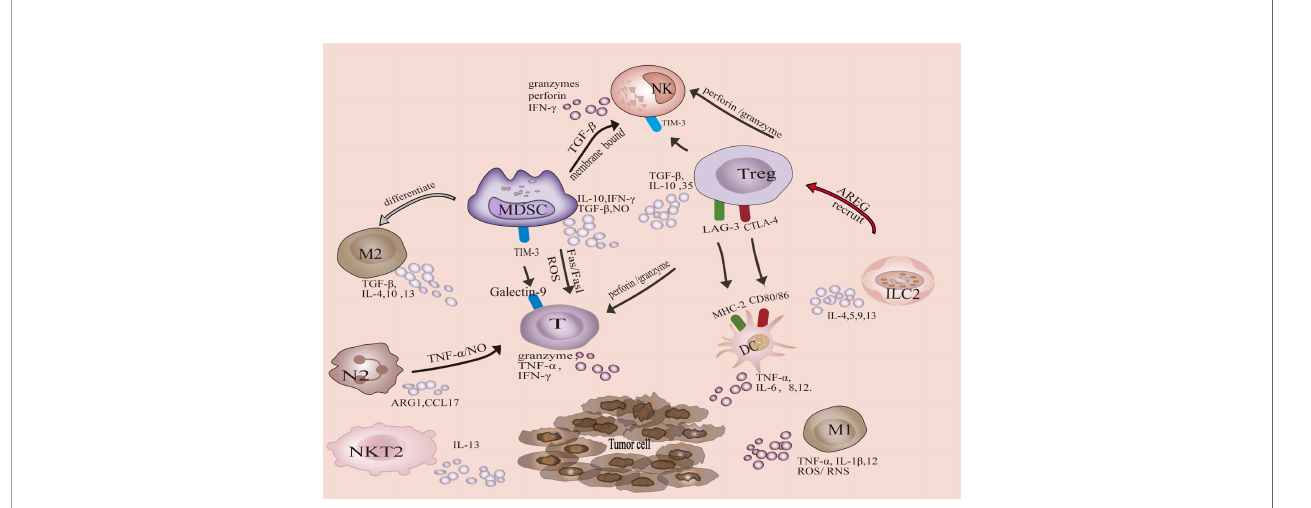
FIGURE 1 | Crosstalk of tumor-associated immune cells in tumor